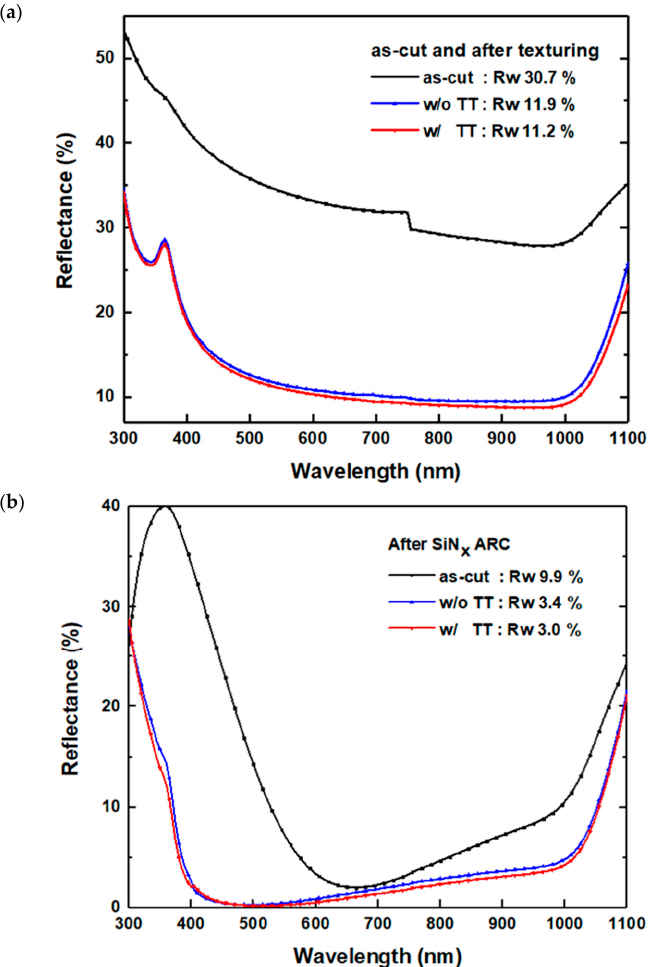
Figure 6. Reflectance curves of DWS mono-Si wafers: ( a ) as-cut and textured; ( b ) after deposition of anti-reflection coating. The values of weighted average reflectance (R w ) in the wavelength range of 300–1100 nm are additionally shown.